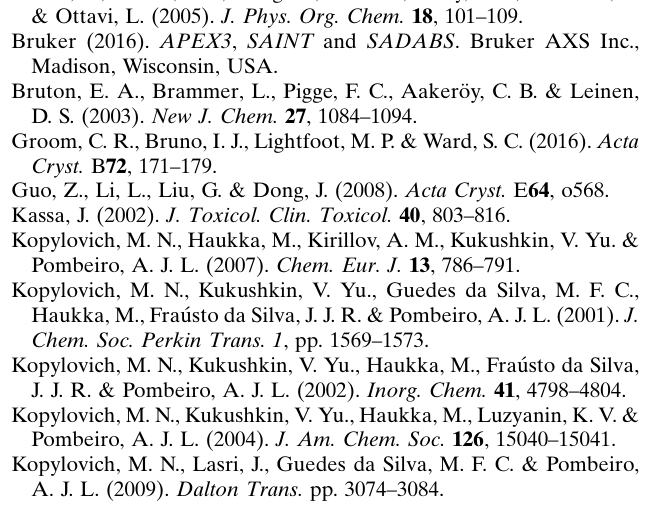
Crystal data Chemical